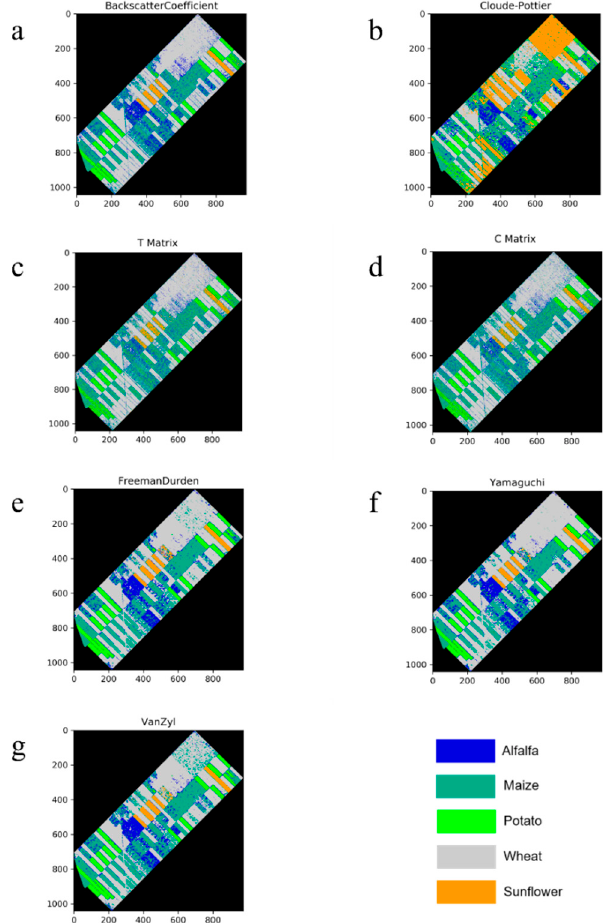
Figure 7. Classified images (( a ): Backscatter Coefficient, ( b ): Cloude-Pottier Decomposition, ( c ): T Matrix, ( d ): C Matrix, ( e ): Freeman-Durden Decomposition, ( f ): Yamaguchi Decomposition, and ( g ): Van Zyl Decomposition).